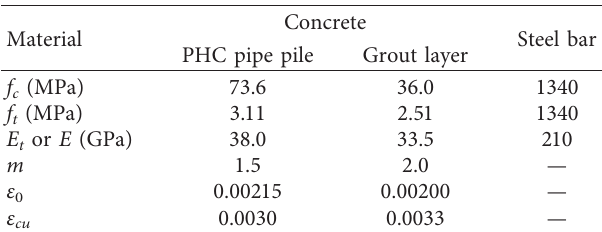
Figure 5: Effect of cracks on the bending behavior: (a) curvature-moment curves; (b) moment- EI curves. Table 2: Parameters used in the calculation of M-EI relationship of